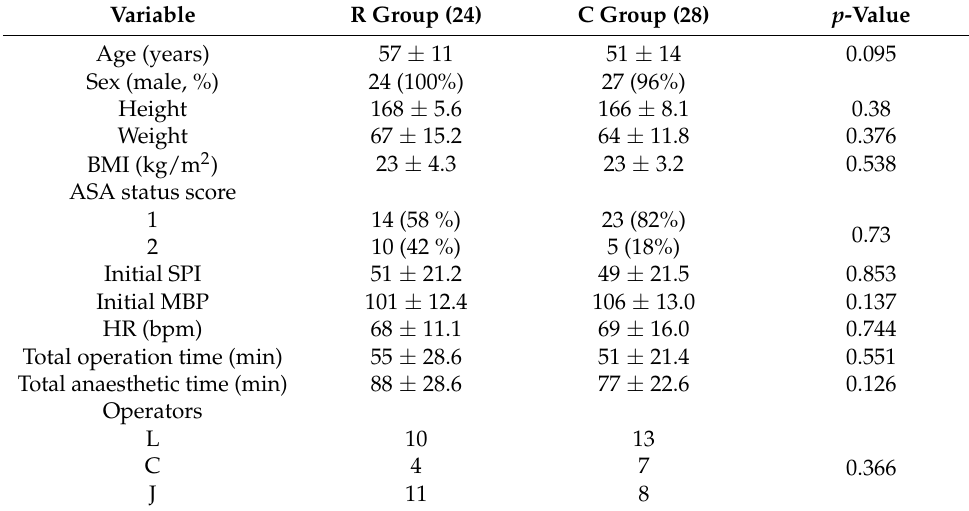
Table 1. Patient characteristics.